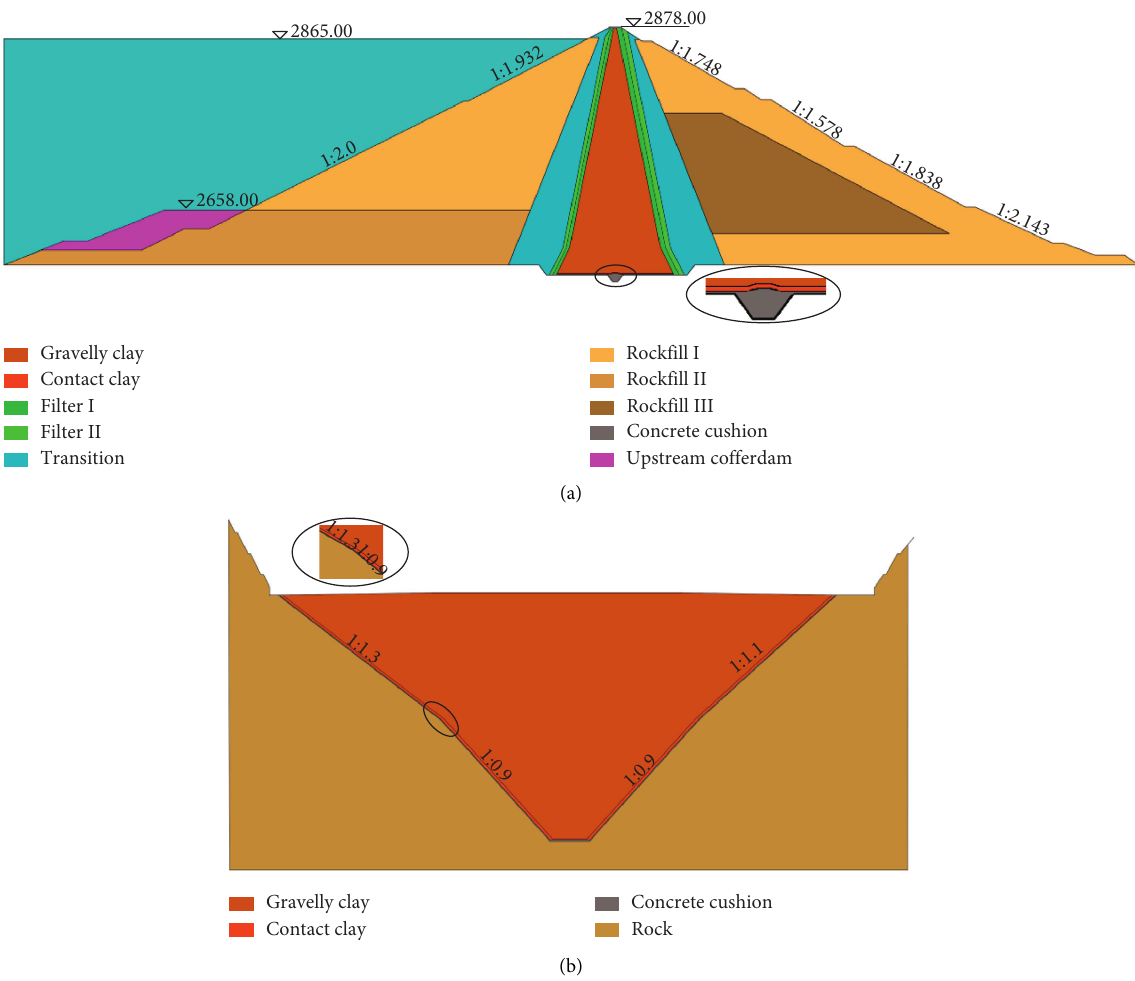
Figure 1: Typical section of the Lianghekou earth core rockfill dam. (a) Maximum cross section. (b) Maximum axial